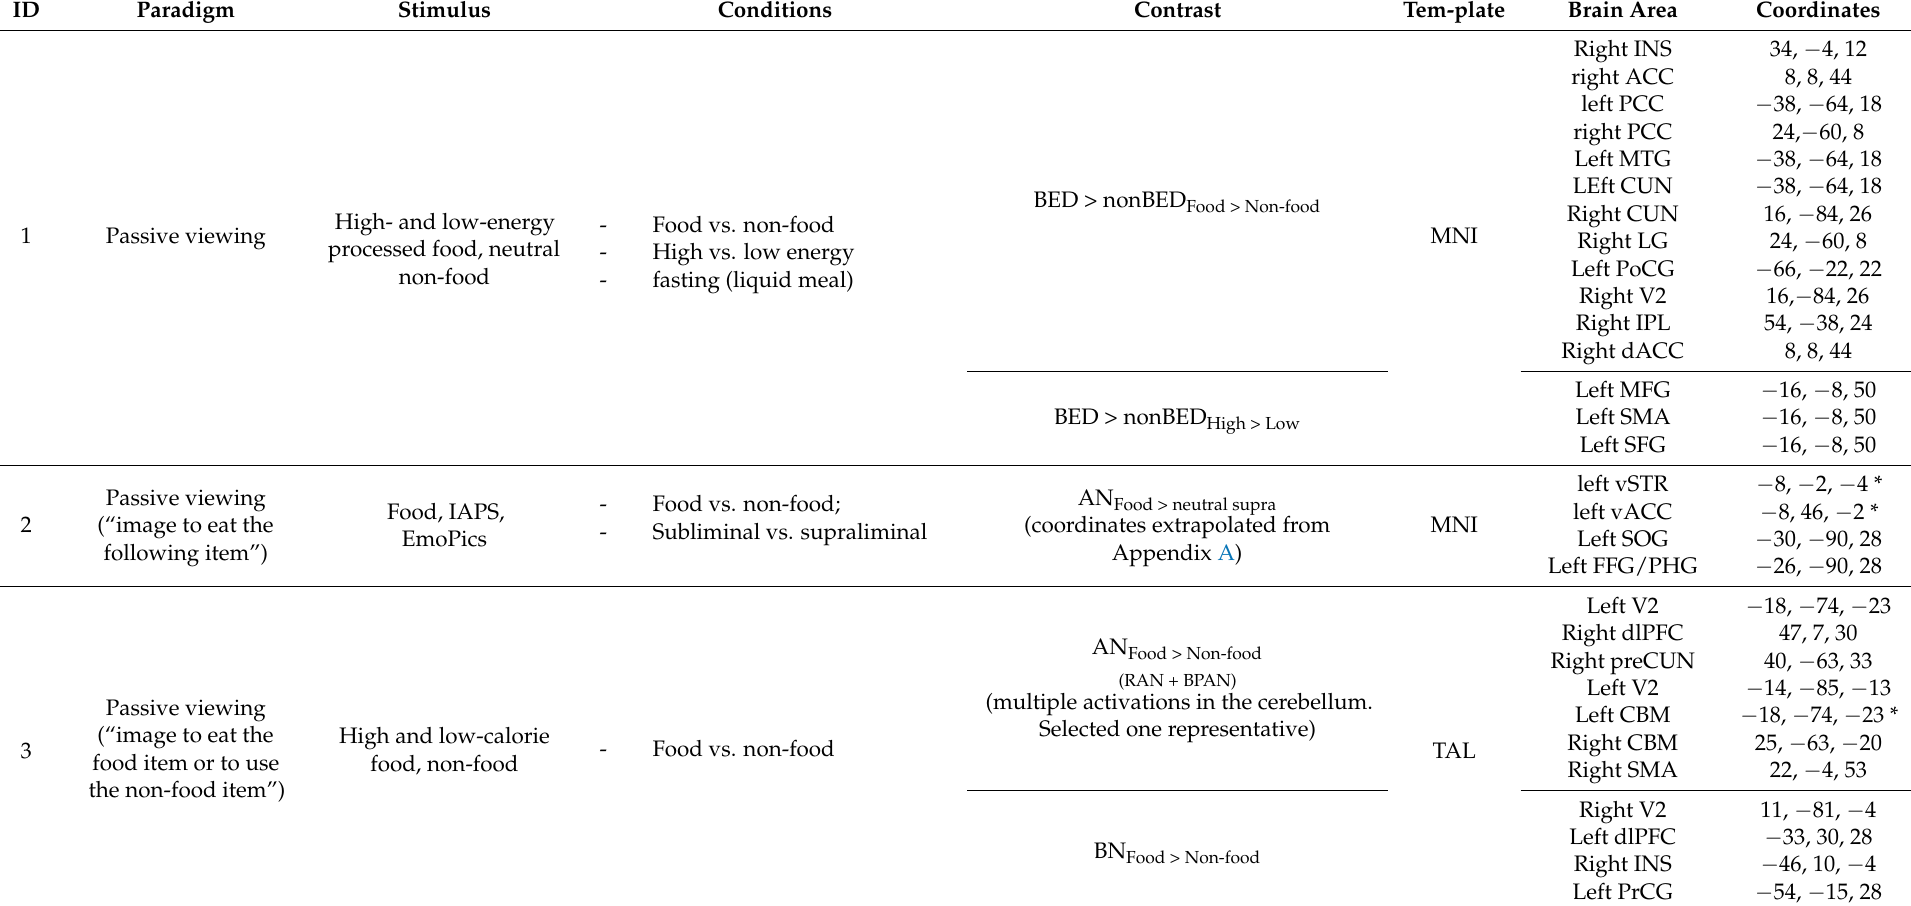
Table A1. Main results that emerged from the analysis of selected